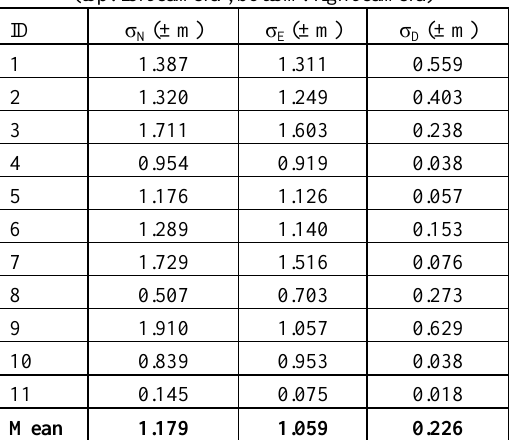
(top: left camera , bottom: right camera)